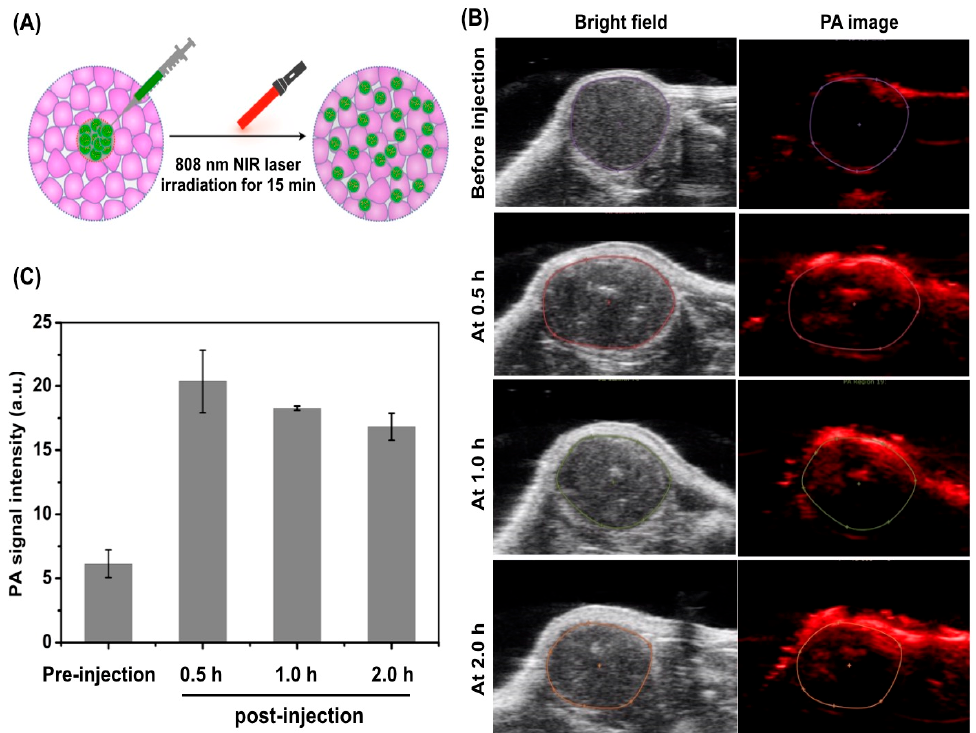
Figure 4. Intratumoral distribution of CuS- 131 I-PEG nanotheranostics in vivo. ( A ) Schematic illustration of intratumoral distribution of CuS- 131 I-PEG nanotheranostics after mild hyperthermia stimulation through 808 nm NIR laser irradiation for 15 min. ( B ) Photoacoustic signals of distribution of CuS- 131 I-PEG nanotheranostics inside tumors for 2.0 h. ( C ) Quantitative analysis of photoacoustic signal intensity of 131 I in ( B ).